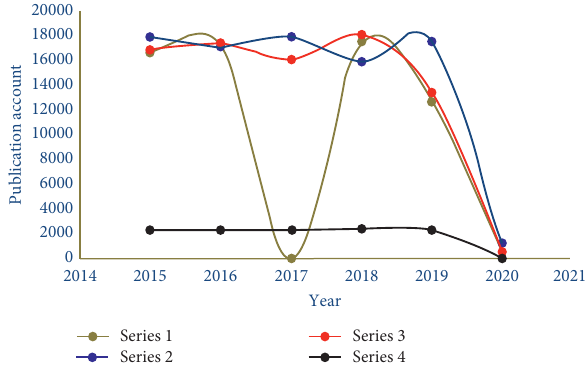
Figure 4: Number of publications since 2015 to 2020 for each time horizon returned by Google Scholar